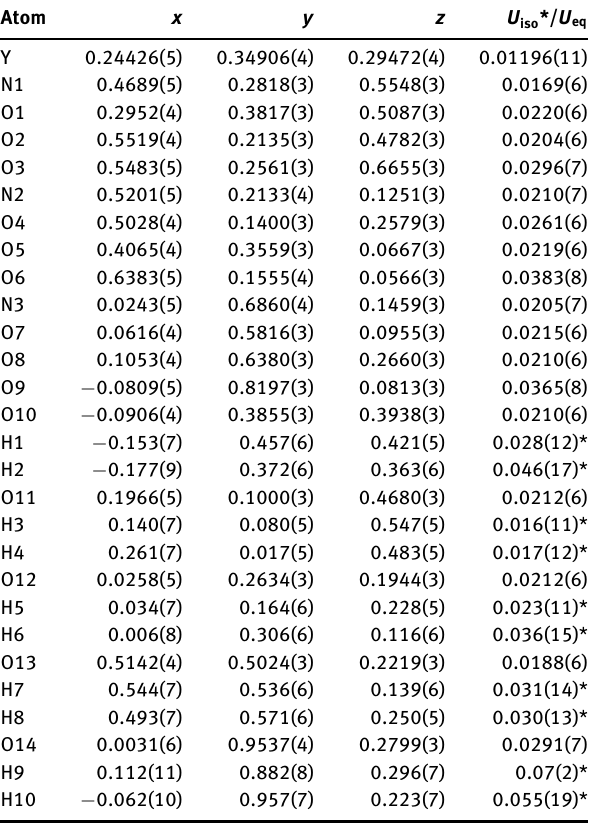
Table 2: Fractional atomic coordinates and isotropic or equivalent isotropic displacement parameters (Å 2